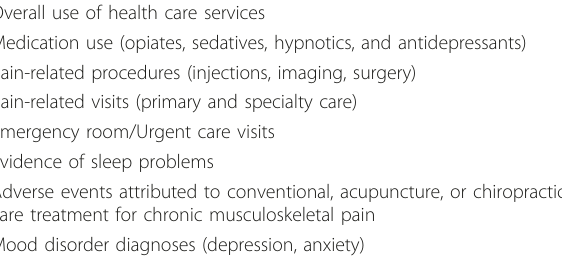
Table 4 Phase 1: EMR-derived Clinical Outcomes Overall use of health care services Medication use (opiates, sedatives, hypnotics, and antidepressants) Pain-related procedures (injections, imaging, surgery) Pain-related visits (primary and specialty care) Emergency room/Urgent care visits Evidence of sleep